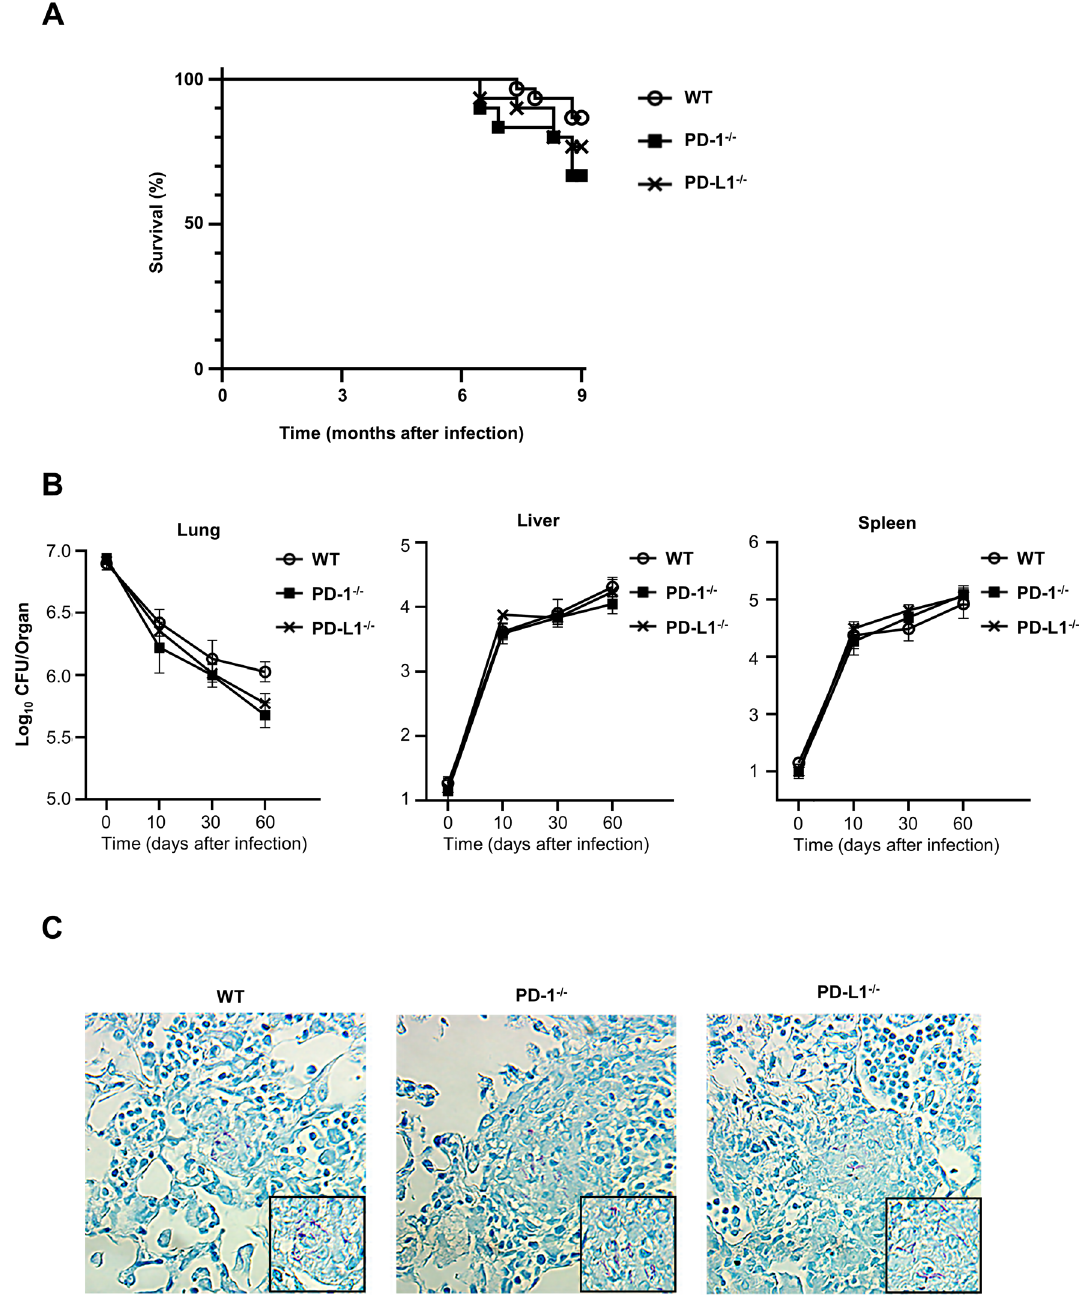
Figure 1. Depletion of PD-1/PD-L1 did not affect susceptibility to M. avium . ( A ) Survival of wild-type, PD- 1 −/− , and PD-L1 −/− mice after intranasal inoculation of 1 × 10 7 CFU of MAC or saline (n = 30 in each group). ( B ) Mycobacterial outgrowth in the lung, liver, and spleen of wild-type, PD-1 −/− , and PD-L1 −/− mice at 0, 10, 30, and 60 days after intranasal inoculation of 1 × 10 7 CFU of MAC. The results are expressed as CFU per organ. The experiments were performed in duplicate with eight mice in each group. Data are expressed as means ± SEM. Significance was defined as a P value of < 0.05. ( C ) Representative photographs of Ziehl–Neelsen staining of lungs (× 400). Insets show acid-fast bacilli at higher of mRNA transcripts on infection with MAC bacteria in each genotype, a comparison analysis was performed using RNA-seq data. Sixty days after MAC inoculation, differentially expressed (DE) genes between lungs of infected and uninfected mice in each genotype with significant differences (FDR-adjusted P ≤ 0.05) and with more than 2.0-fold changes (n = 3 each) were determined. All DE genes are shown in Table E1. IPA was used to identify the canonical pathways that were enriched for these DE genes 60 days after MAC infection (Table E2). Table 1 shows the top 10 significantly enriched canonical pathways in infected wild-type lungs as compared with uninfected wild-type lungs. The majority of these 10 pathways were related to Th1 immunity, such as the ‘Th1